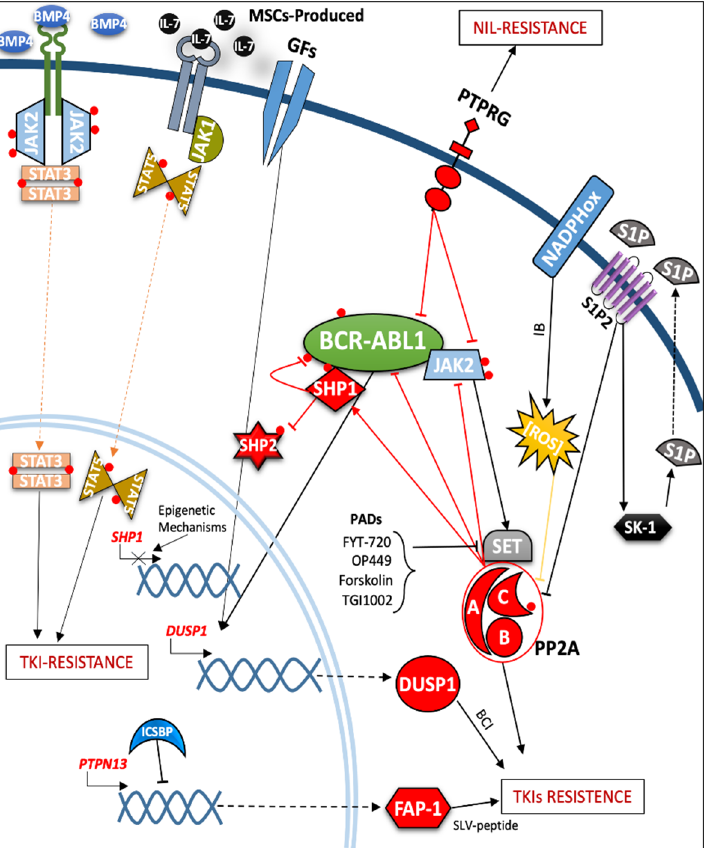
Figure 4. Schematic representation of the role played by kinase and phosphatases in the resistance or sensitization mechanisms to TKIs in CML. GFs = growth factors; ROS = reactive oxygen species; PADs = PP2A activating drugs; NADPHox = nicotinamide adenine dinucleotide phosphate oxidase; MSCs = mesenchymal stem cells; BMP 4 = bone morphogenetic proteins; STAT = signal transducer and activator of transcription.